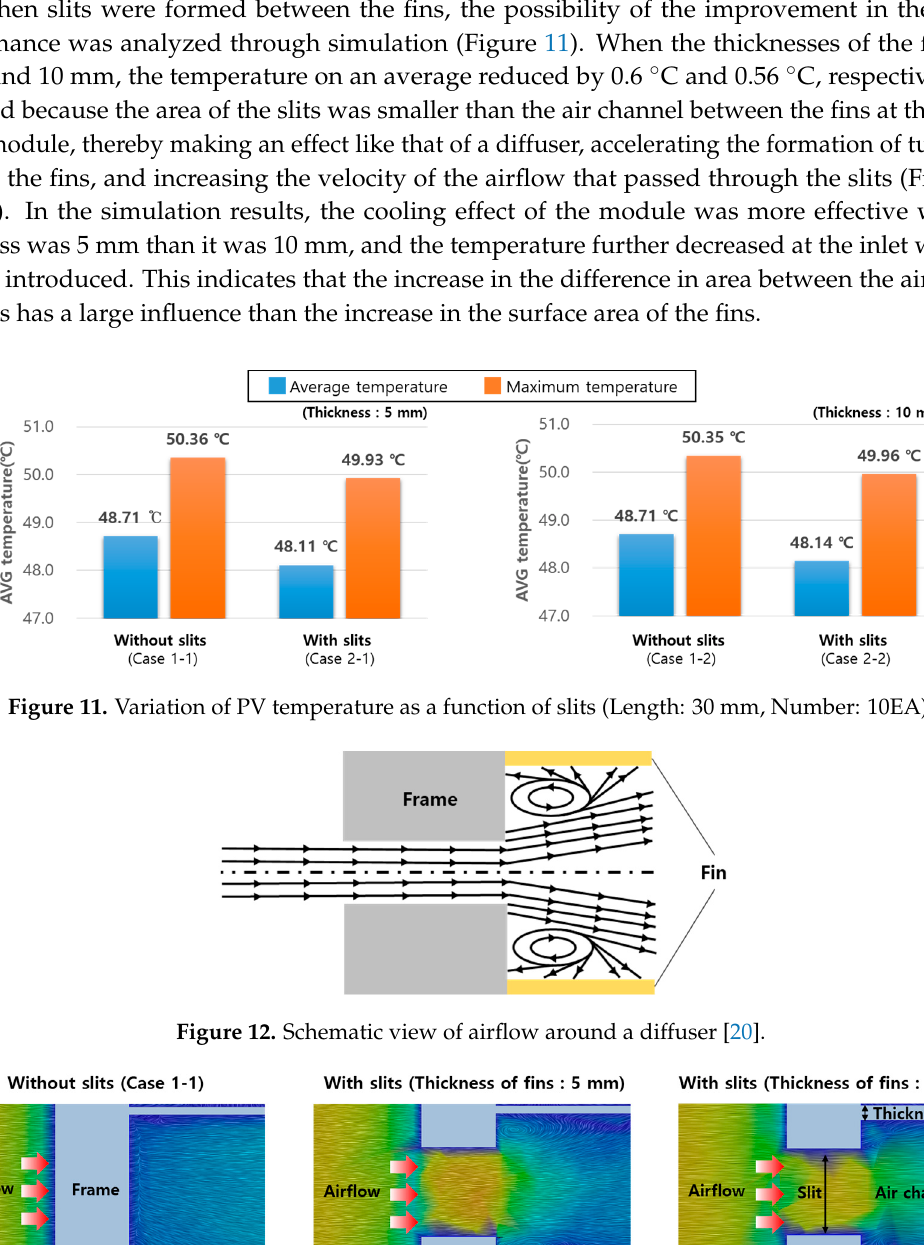
Figure 10. Variation of PV temperature as a function of fins.